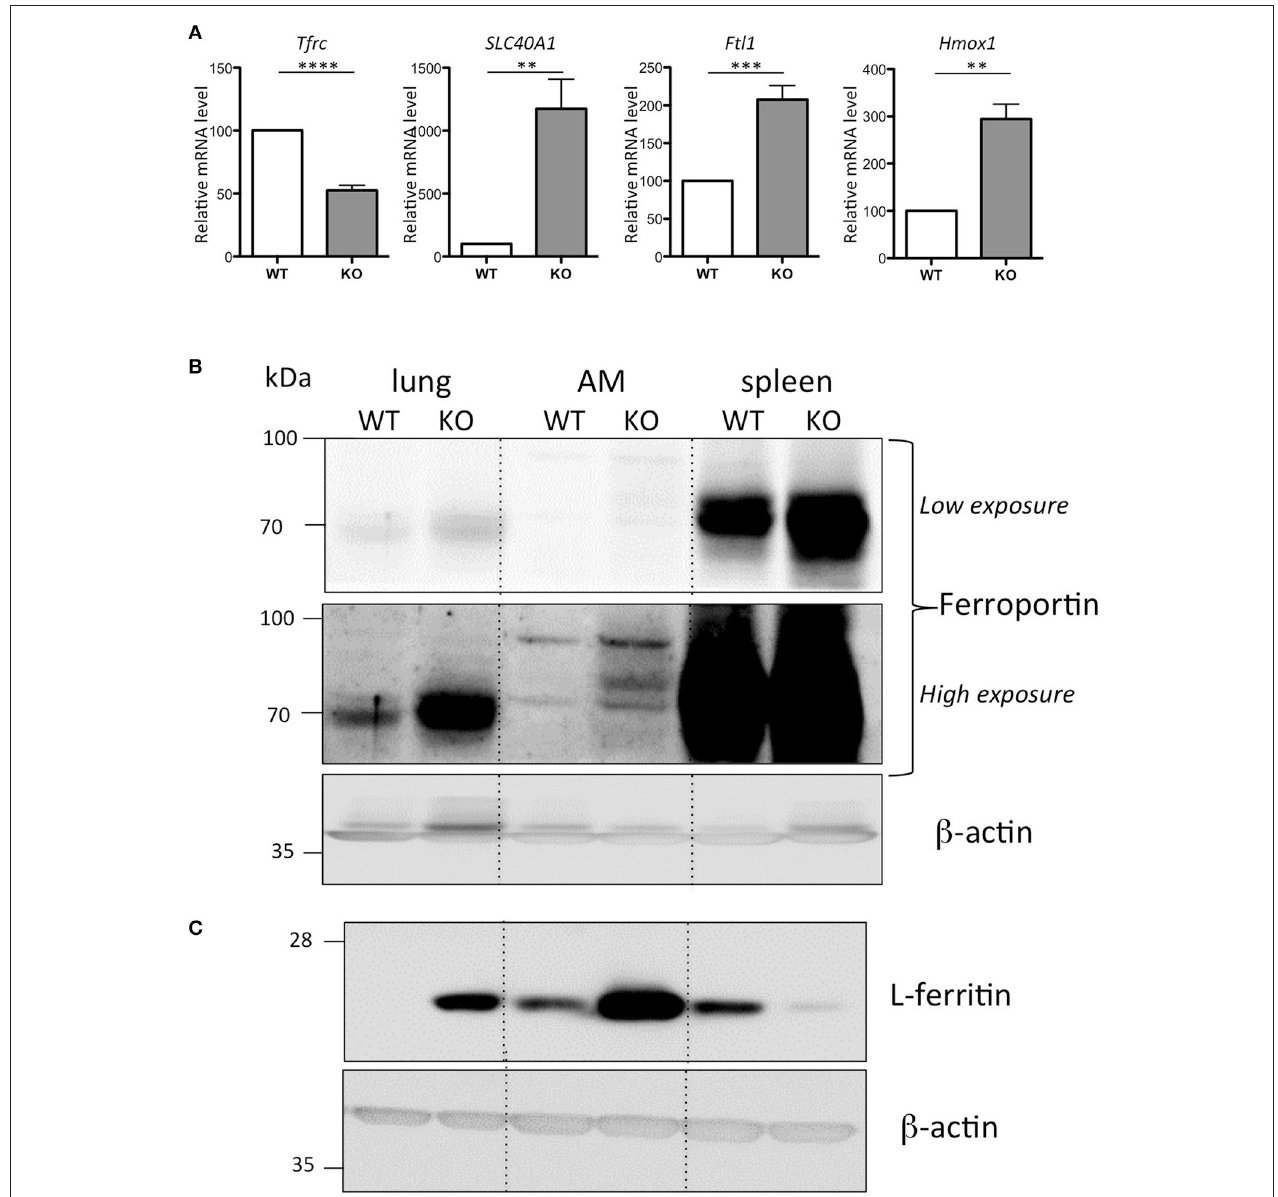
FIGURE 4 | Iron phenotype of the isolated AM from WT and Hepc KO mice: Tfrc , Slc40A1 , Ftl1, and Hmox1 mRNA levels in AM relative to Ppia analyzed by real-time PCR. The WT AM cells have been used as reference for each single experiment of AM isolation performed on an-age matched couple of WT and Hepc KO mice, and the data are expressed in fold change (A) . Error bars represent SEM for n = 5 KO mice. Statistical significance is indicated by asterisks (** p < 0.01, *** p < 0.001, **** p < 0.0001). Ferroportin (B) and L-ferritin (C) protein levels analyzed by WB using total extract proteins from lung, isolated AM and spleen. For AM, each lane corresponds to the pool of extracts from 3 mice per